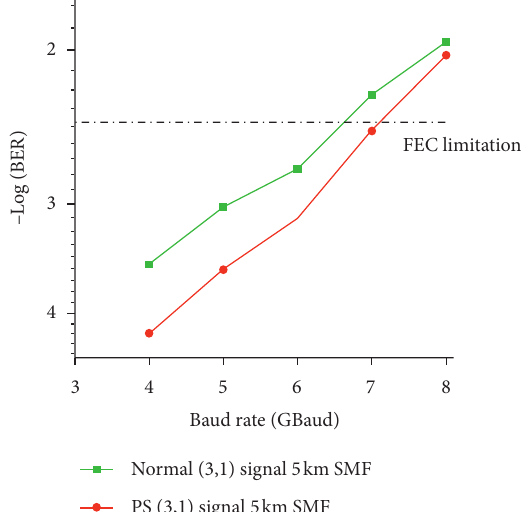
Figure 6: BER of the normal (3, 1) vector signal and the PS (3, 1) vector signal with v � 0.4 versus baud rate for 5km SMF trans- mission at a received optical power of − 23dBm, respectively.